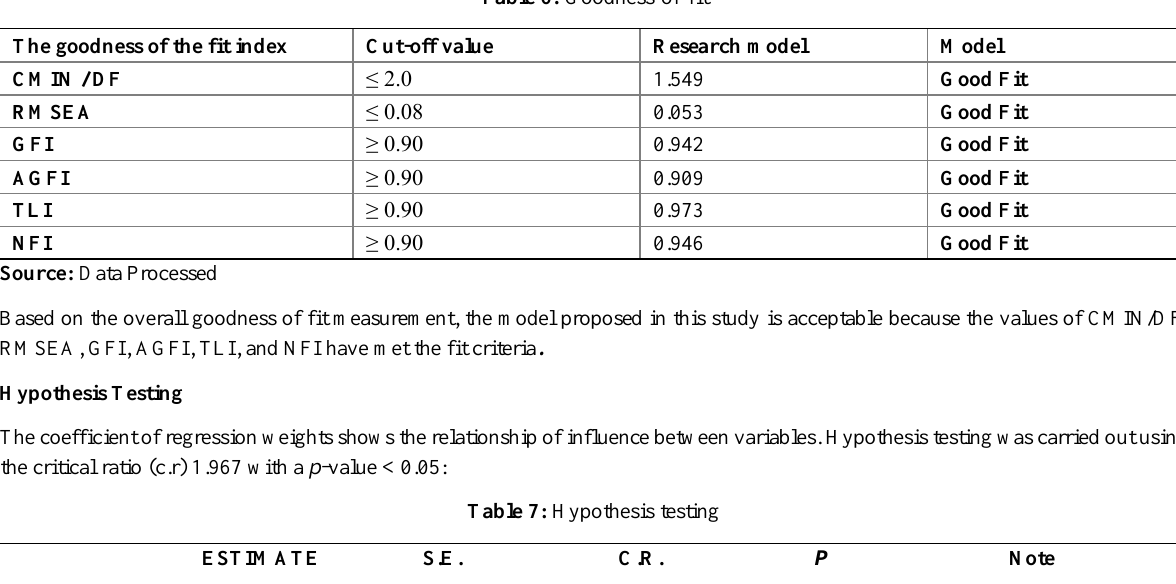
Table 6: Goodness-of-fit